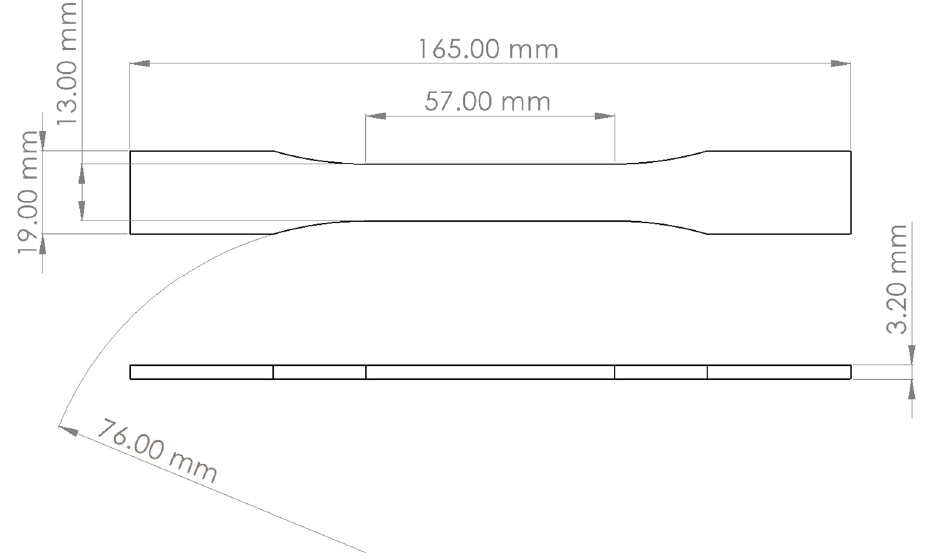
Figure 1. Design, geometry, and dimensions of the 3D printed specimens used for baseline me- chanical characterization following the ASTM D638 02a standards. characterization following the ASTM D638 02a